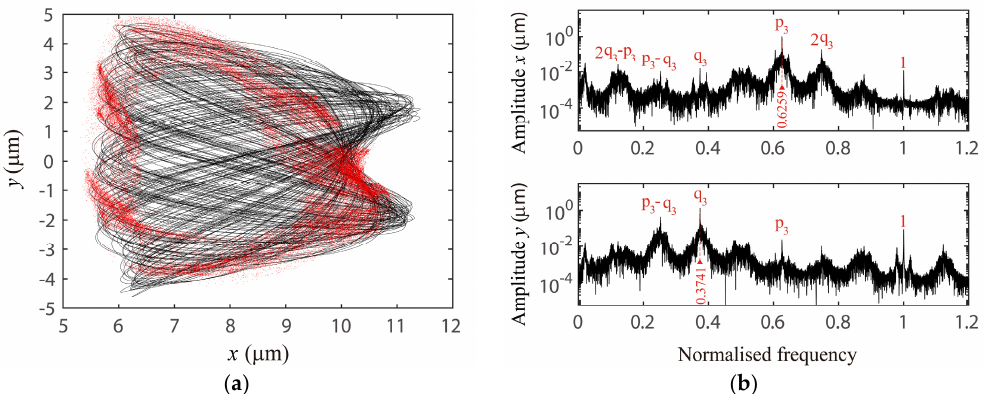
Figure 18. For δ 0 = 4.0 μ m, response characteristics of the VC chaotic motion when Ω = 353 rad/s, ( a ) orbit (black line) and its Poincare mapping (red dots), ( b ) frequency spectrum.